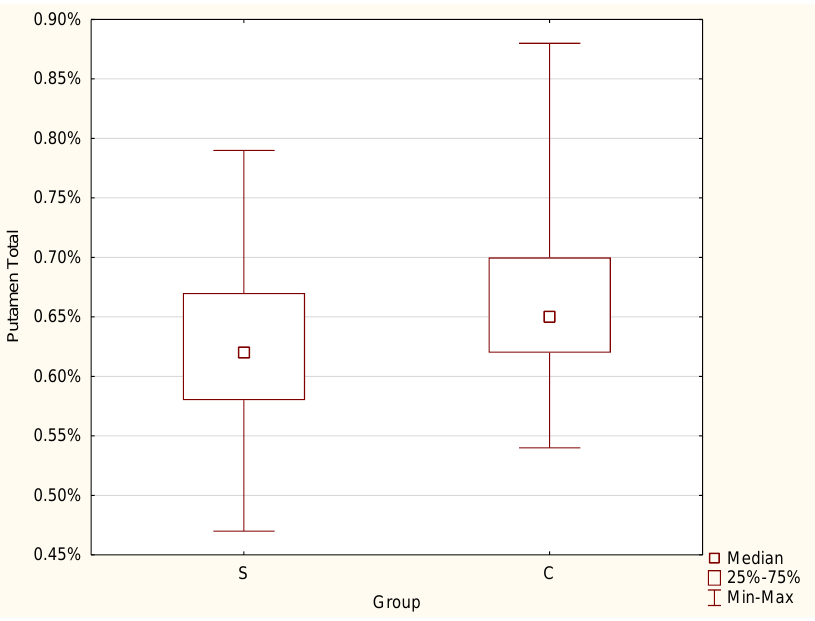
Figure 8. Differences in putamen volume between the C and S groups. The results for the other tested factors indicated non-significant differences between the groups (S and C). Nevertheless, there is a definite declining trend in the volume of remaining structures in patients with epilepsy as compared to healthy patients. Next, the results from the volBrain program were analyzed according to the presence of comorbidities in a group of children with epilepsy. The following comorbidities/condi- tions were included in the analysis: prematurity, delayed development, cerebral palsy, the presence of arachnoid cyst, Recklinghausen ’ s disease, undefined CNS defects, mental dis- ability, speech disorders, hearing loss and factor XII deficiency; however, due to the small number of distributed variables, the analysis was based on two variables — the absence or presence of comorbidities. Although no significant differences were observed between the groups, patients with comorbidities showed bigger brain atrophy (90.11 vs. 90.55% of the IC), and greater vol- ume of the lateral ventricles (0.98 vs. 0.69% of the IC) (Table 4). Table 4. Comparing the values of particular variables in children with epilepsy. Descriptive statis- tics (N, median with lower and upper quartiles) with the statistical analysis (Mann – Whitney U test); statistically significant difference marked by “*” (asteri sk). Factor